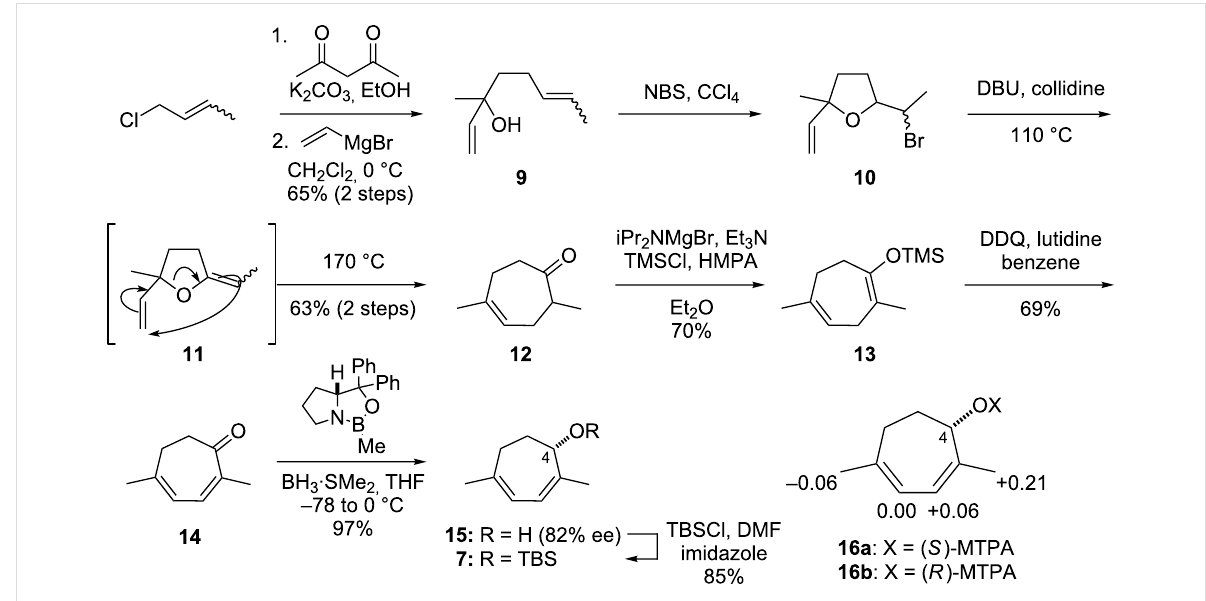
Scheme 2: Asymmetric synthesis of 7 and determination of the absolute configuration at C4 of 15 by the modified Mosher method. The numbers are differences in 1 H chemical shifts between 16a and 16b ( Δδ = δ 16a − δ 16b ).